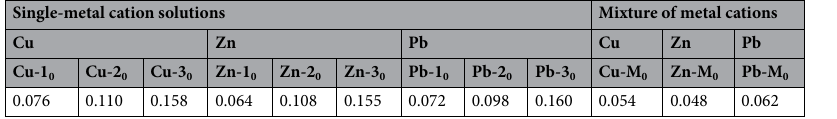
Table 1. The initial concentrations of metals c M(0) (mmol L −1 ) in solutions used for their removal.